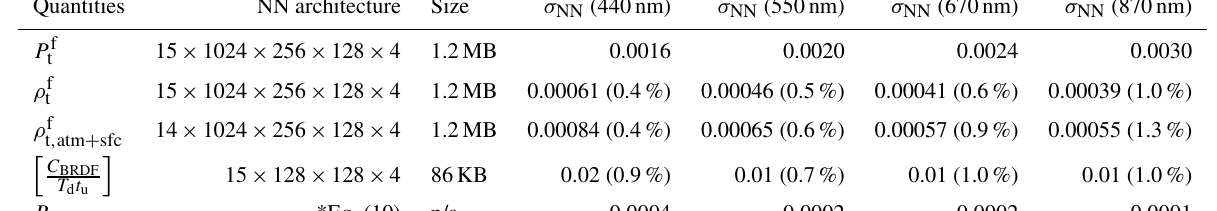
Table 3. The accuracy of the NN for the corresponding quantities in terms of the RMSE ( σ NN ) of the difference between the NN-predicted values and the truth values from radiative transfer simulation. The NN architecture denotes the number of the nodes in each layer. The corre- sponding NN data sizes are indicated. Remote sensing reflectance is computed by Eq. (10) using the NNs for ρ f as discussed in Sect. 3.4. (The percentage values listed below in the parenthesis are the percentage uncertainties defined as the RMSE of the percentage difference between the RT simulation and NN predictions.). n/a means not applicable.